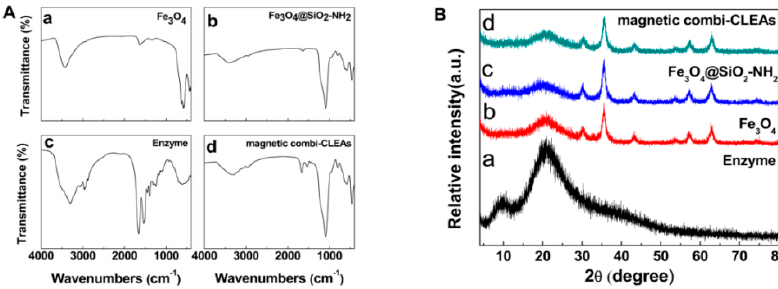
Figure 2. ( A ) FTIR spectra of (a) Fe 3 O 4 ; (b) Fe 3 O 4 @SiO 2 -NH 2 ; (c) free enzyme; (d) magnetic combi-CLEAs. ( B ) XRD of (a) free enzyme; (b) Fe 3 O 4 ; (c) Fe 3 O 4 @SiO 2 -NH 2 ; (d) magnetic combi-CLEAs.